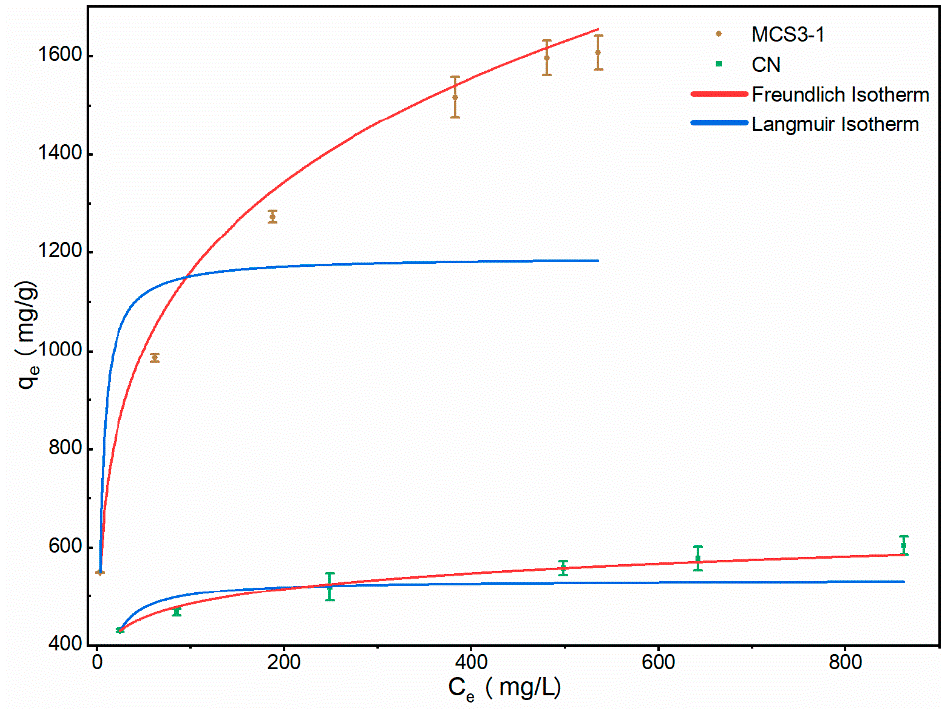
Figure 14. Langmuir and Freundlich isotherm plots of MCS3 ‐ 1 and CN adsorption of MB. Table 2. Isotherm parameters of MCS3 ‐ 1 and CN adsorption of MB.